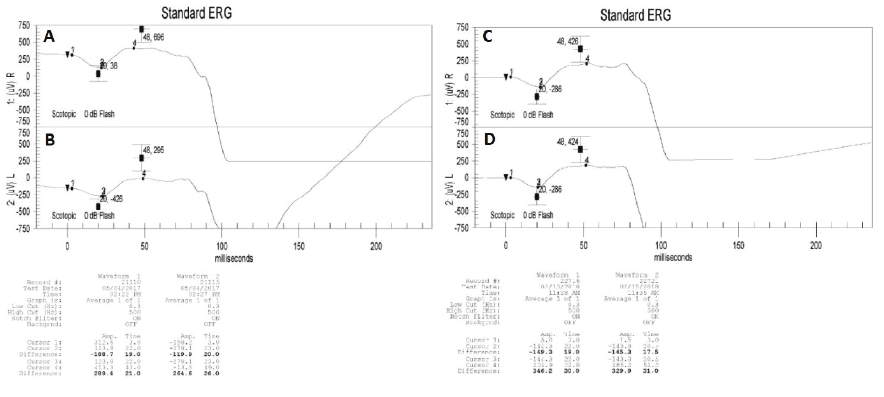
Figure 5. Scotopic combined cone and rod electroretinography (ERG) of the right (A) and left (B) eyes before starting treatment and the right (C) and left (D) eyes 12 months after treatment, which shows an improvement in b-wave amplitude out of proportion in comparison to a-wave amplitude in both